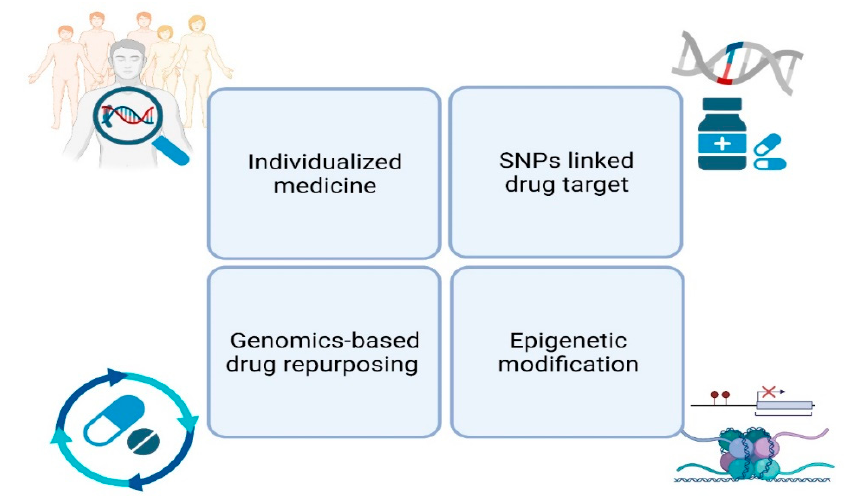
Figure 3. Directions for future studies.